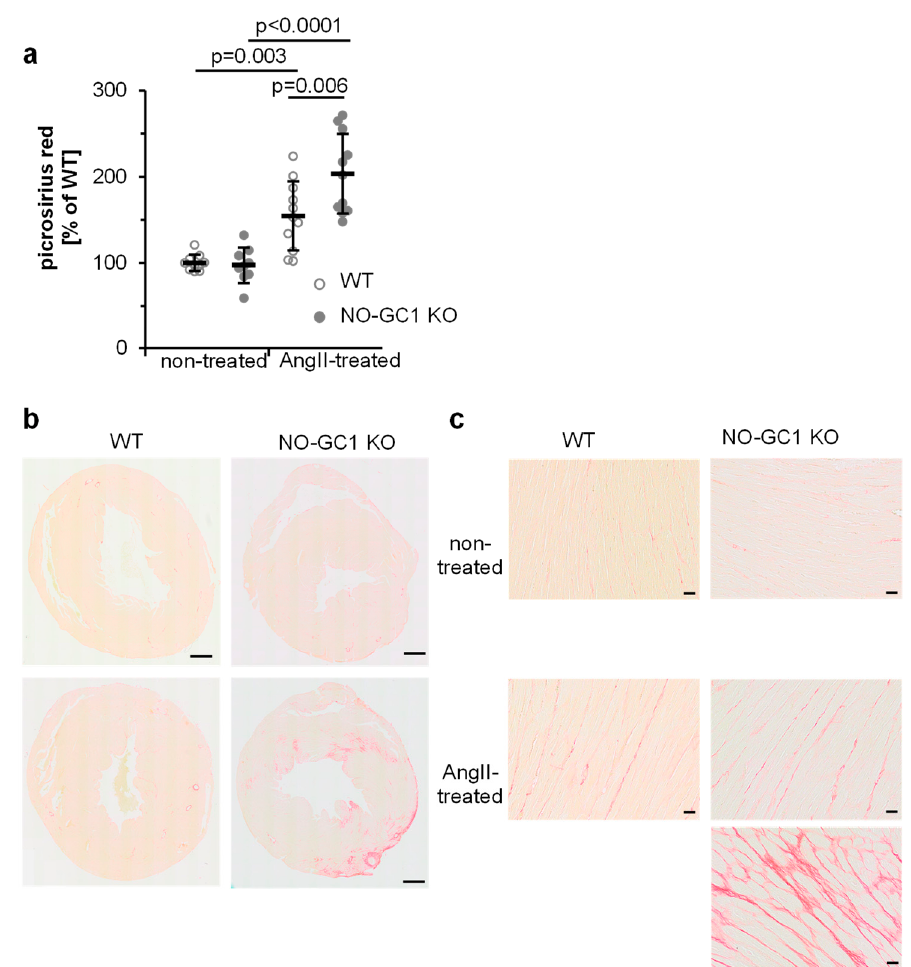
Figure 4. NO-GC-1 KOs display substantially enhanced AngII-induced interstitial fibrosis. ( a ) Picrosirius red-stained areas of hearts ( b , c ) were quantified and normalized to non-treated WT. Shown are individual values (per animal) together with means ± SD. ( b ) Shown are representative paraffin-embedded heart sections (5 µm) stained with picrosirius red. Scale bar, 500 µm ( c ) Shown are magnifications of heart sections stained with picrosirius red. Strongly red stained areas found in NO-GC1 KO hearts were not used for analysis. Scale bar, 20 µm.